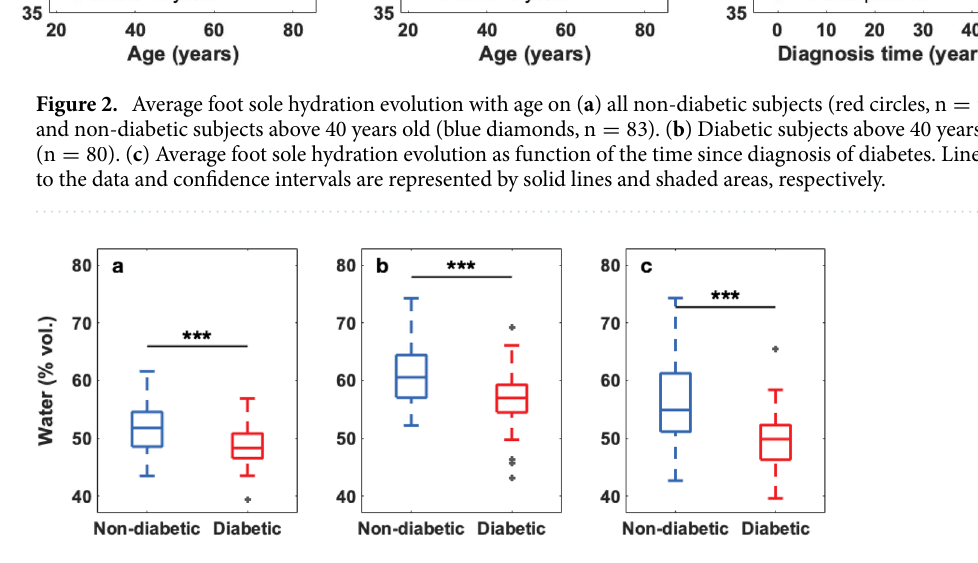
Figure 3. Skin hydration distribution ( a ) averaged over the foot sole ( p = 5.90 × 10 − 4 ), ( b ) at the center of the big toe ( p = 4.30 × 10 − 4 ) and ( c ) at the center of the heel ( p = 8.70 × 10 − 6 ) of non-diabetic ( n = 53, 51, 51 ) and diabetic ( n = 40, 31, 38 ) subjects, only subjects in the age range 40–60 years were considered since this is the region where there is significant population overlap in both groups, and either the toe or the heel of some subjects was excluded from the analysis for individual reasons such as previous amputation, local image occlusion owing to the presence of a bandage, etc. The box represents the middle 50% of the data, 25% of the data is below the lower bar, the middle bar represents the median and 75% of the data relies below the upper bar. The dark grey crosses indicate the outliers and the statistical significance is denoted by black stars displayed over the